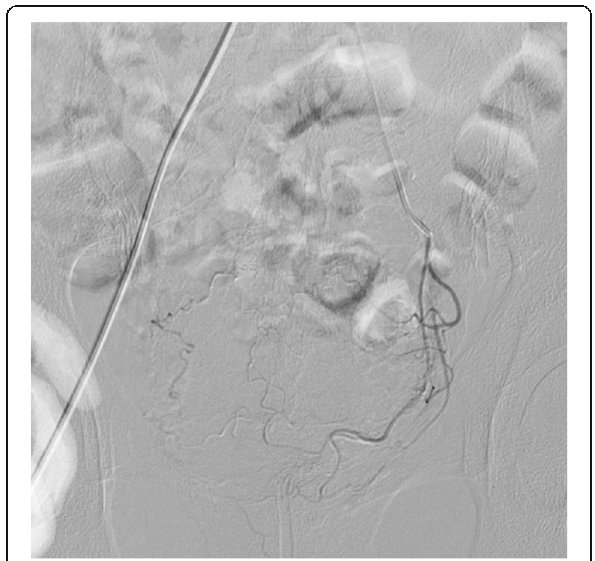
Fig. 2 Finishing embolization on the left